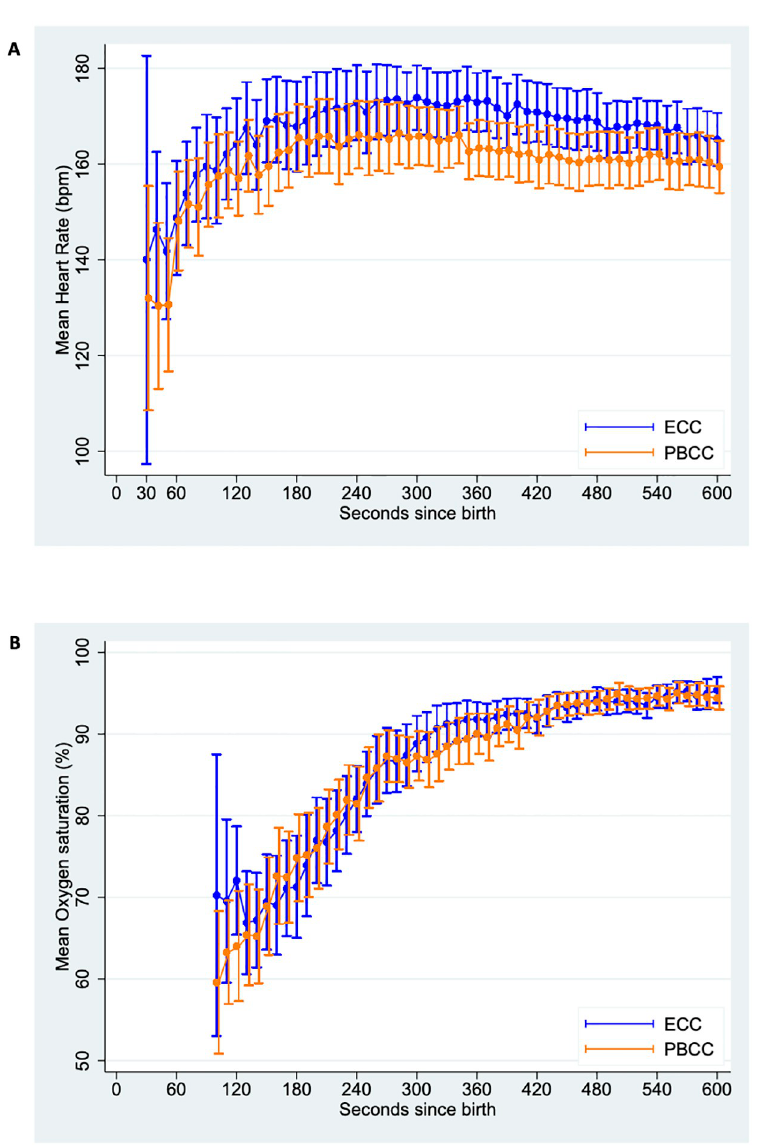
Fig 2. Mean heart rate (A) and oxygen saturation (B) measured at 10-second intervals from 30–600 seconds from birth for infants in the PBCC and ECC arms. Error bars represent 95% CI. CI, confidence interval; ECC, early cord clamping; PBCC, physiologically based cord